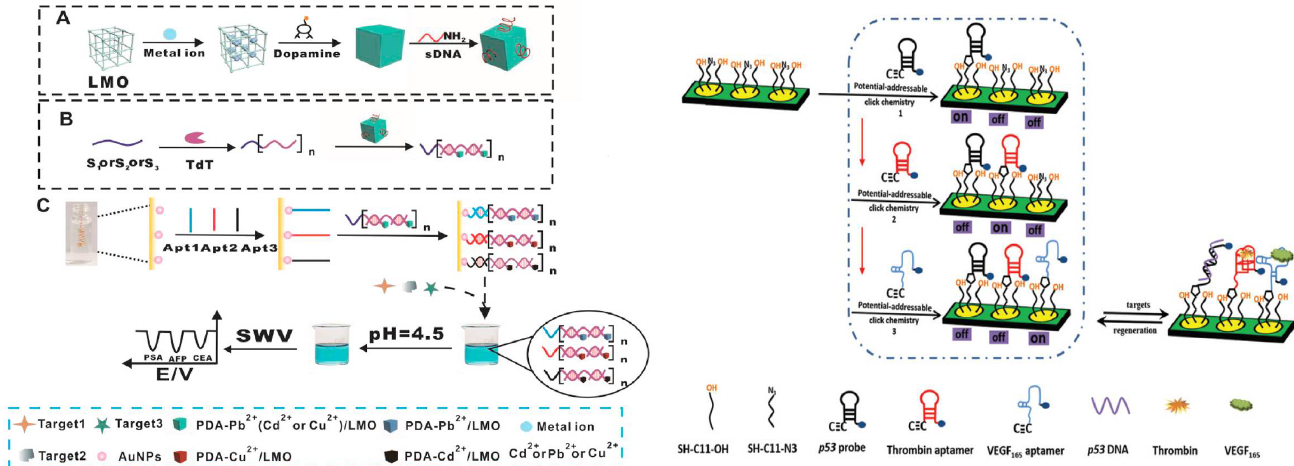
Figure 8. Aptasensors for multiplex detection of biomarkers ( left panel ) based on hyperbranched DNA-LaMnO 3 perovskite (DNA-LMO) nanobiocomposites probes loaded with metal ions [276], Copyright (2021) Elsevier, reprinted with permission, and ( right panel ) based on a three-channel carbon SPCE selectively modified with DNA probes specific for three different analytes, reproduced from ref. [277] with permission from The Royal Society of Chemistry.